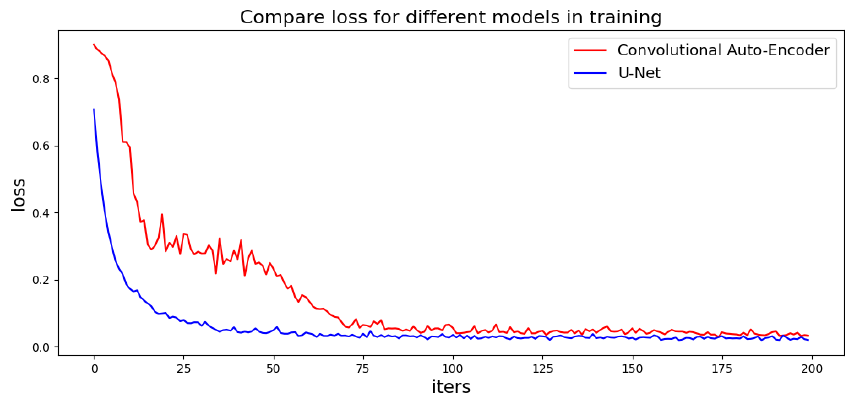
Figure 3. Loss of generators in training.